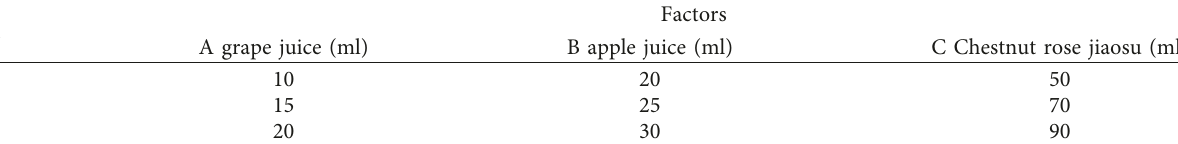
Table 5: Juice blending orthogonal